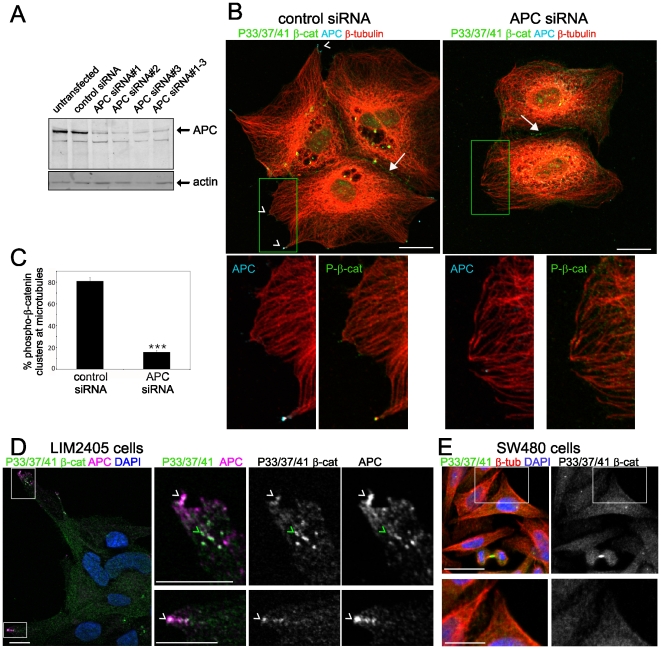
APC is required for phospho-β-catenin localisation to the ends of microtubules.(A) Depletion of cellular APC by siRNA. APC levels following siRNA transfection were assessed by immunoblot analysis in cell lysates. Actin was used as a loading control. (B) MDCK cells transfected with control and APC siRNA were immunostained for P33/37/41-β-catenin (green), APC (cyan) and β-tubulin (red) with APC/β-tubulin and P33/37/41-β-catenin/β-tubulin enlarged in insets shown below. Arrowheads indicate clusters of phospho-β-catenin at microtubule ends coincident with APC in control but not APC depleted cells. Scale bars 20 µm. (C) Quantification of phospho-β-catenin clusters (%) at microtubule protrusions in control and APC siRNA treated cells. Shown is average +/− SD from 3 independent experiments, >70 microtubule protrusions per treatment group. ***P<0.001 by Student's t-test. (D) LIM2405 colon cancer cells containing a wt APC allele demonstrate concentrations of P33/37/41-β-catenin (green) at cell extensions that partially overlap with APC (magenta) (white arrowheads indicate overlap with APC, green arrowheads indicate concentrations of P33/37/41-β-catenin that do not overlap with APC). Nuclei were visualised with DAPI; scale bars 10 µm. (E) P33/37/41-β-catenin is diffusely cytoplasmic in SW480 colon cancer cells and does not concentrate in clusters at microtubule ends. SW480 cells were immunostained with P33/37/41-β-catenin (green) and β-tubulin (red) and costained with DAPI to visualise nuclei, scale bar 20 µm. P33/37/41/β-tubulin and P33/37/41-β-catenin enlarged in insets are shown below, scale bar 10 µm.